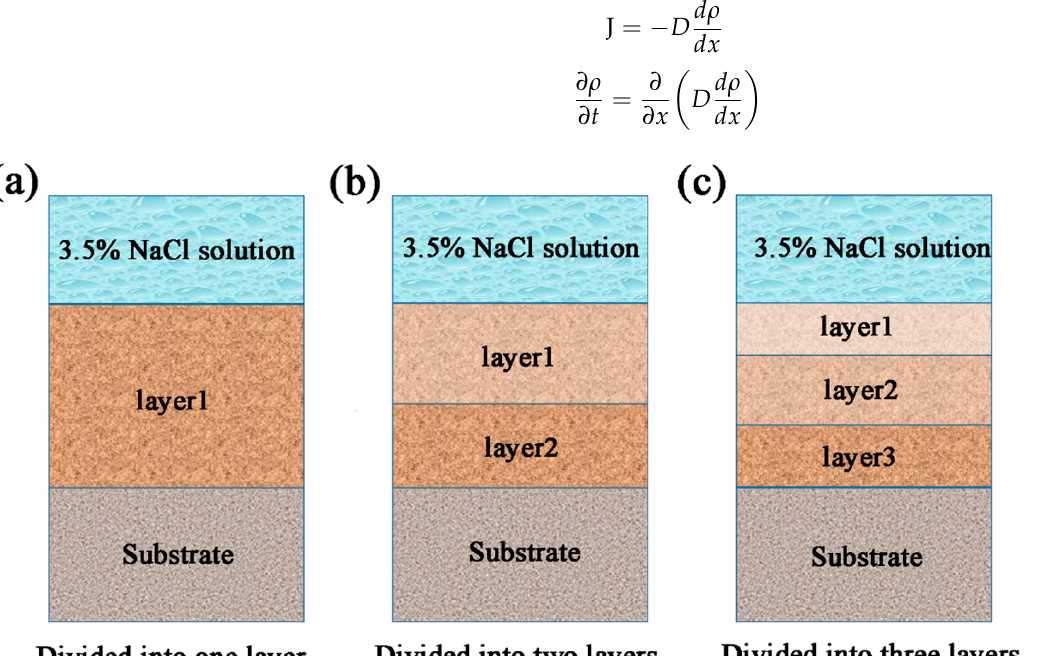
Figure 5. Schematic diagram of layering. ( a ) When the coating is just soaked, the corrosive medium does not invade, and it is divided into one layer. ( b ) The corrosive medium intrusion is divided into two layers. ( c ) The corrosive medium intrusion is divided into three layers. Circuit diagram 1: early stage (the corrosive medium has not yet penetrated the coat- ing). Circuit diagram 2: intermediate stage 1 (the corrosive medium’s intrusion into the